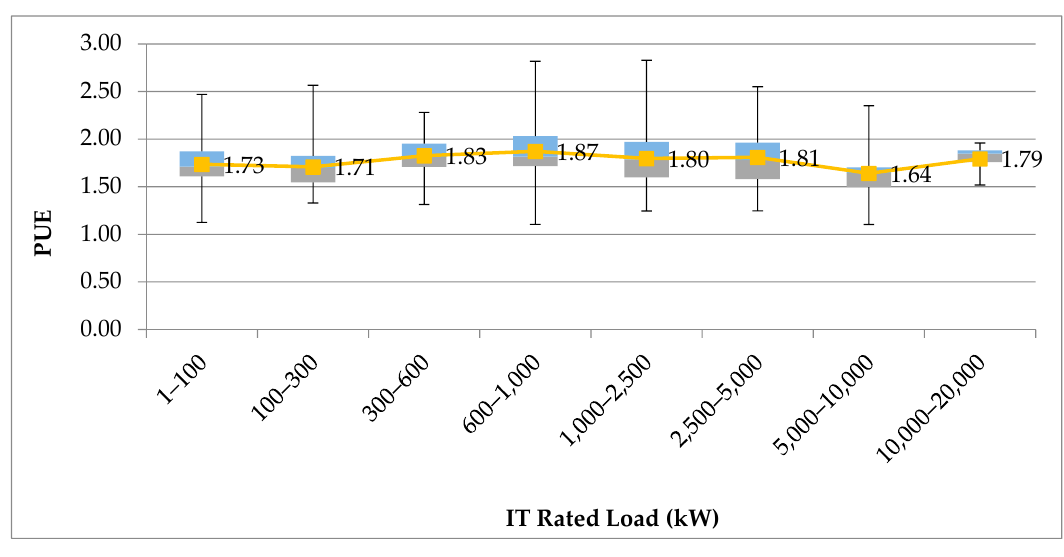
Figure 6. Average PUE values for different IT rated load classifications (kW).